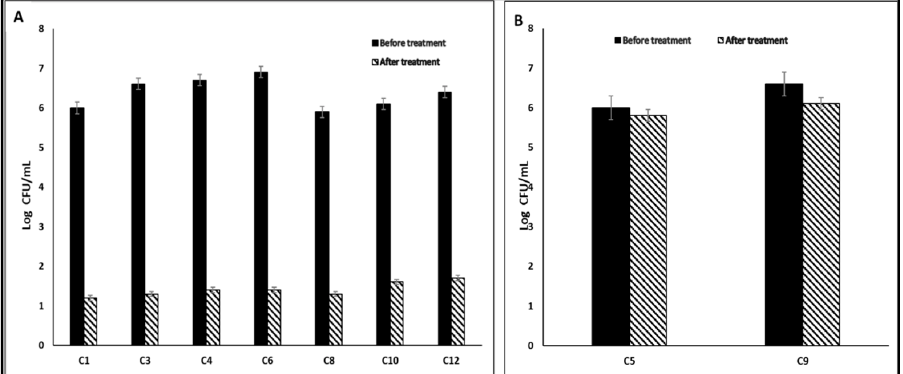
Table 2. Impact of AgNPs on biofilm formation by C. albicans isolates.